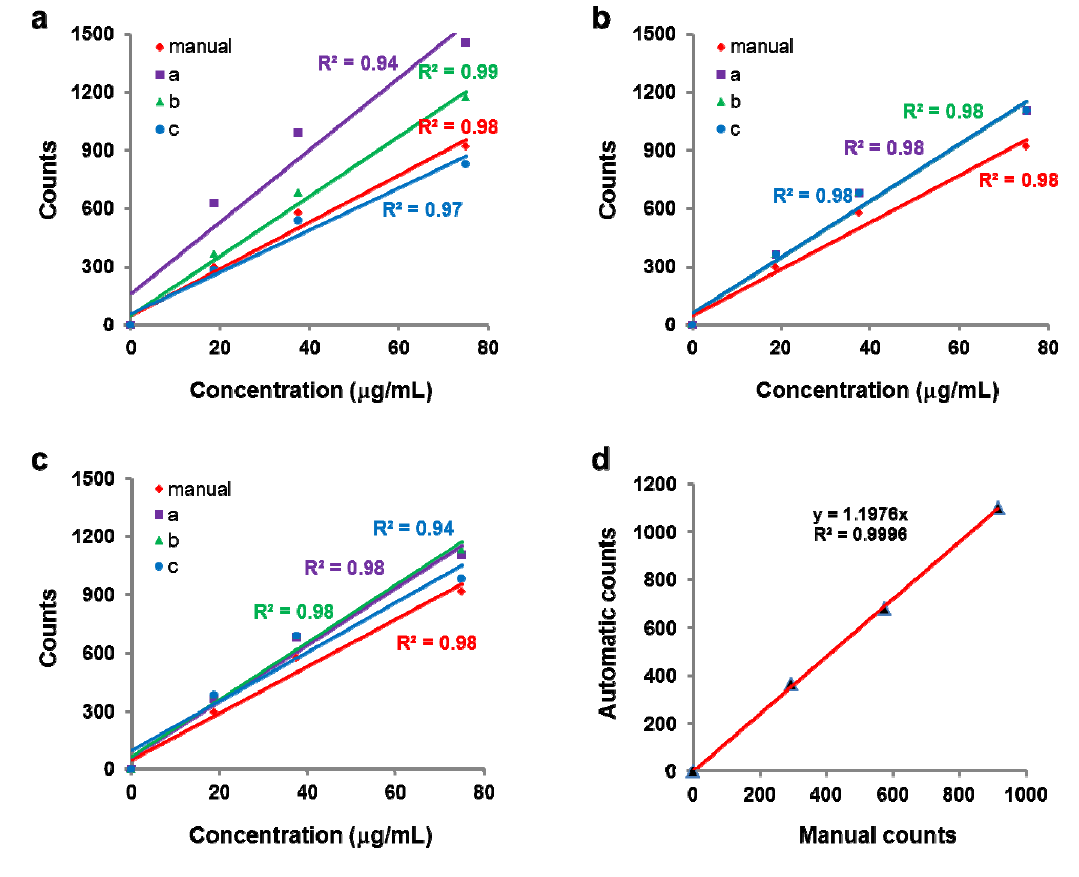
Figure 4. Total fiber counts versus asbestos concentration affected by change in the parameter for (a) “Auto Local Threshold” process (radius: a = 2, b = 5, c = 10); (b) “Threshold” process ({min, max}: a = {50, 170}, b = {0, 40}, c = {30, 255}): the changes in the threshold value are insignificant and a, b and c are completely overlapped; and (c) “Analyze Particles” process (size: a = 50–5,000, b = 10–5,000, c = 10–10,000); (d) Correlation between manual counts and automatic counts from HTM analysis with respect to the asbestos